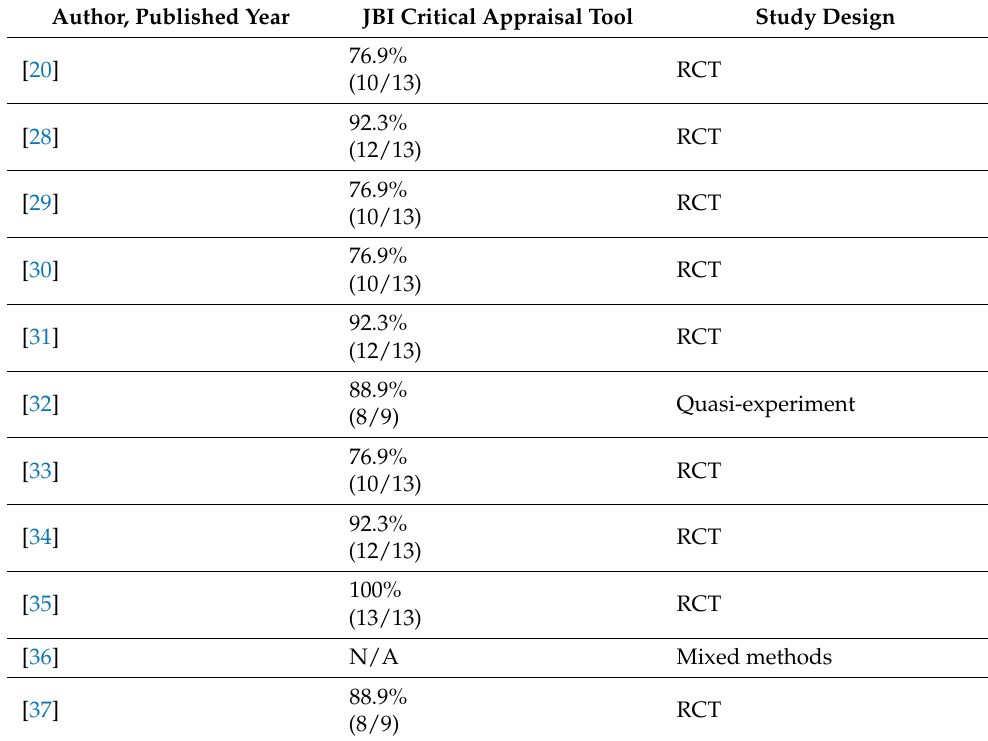
Table 1. JBI critical appraisal